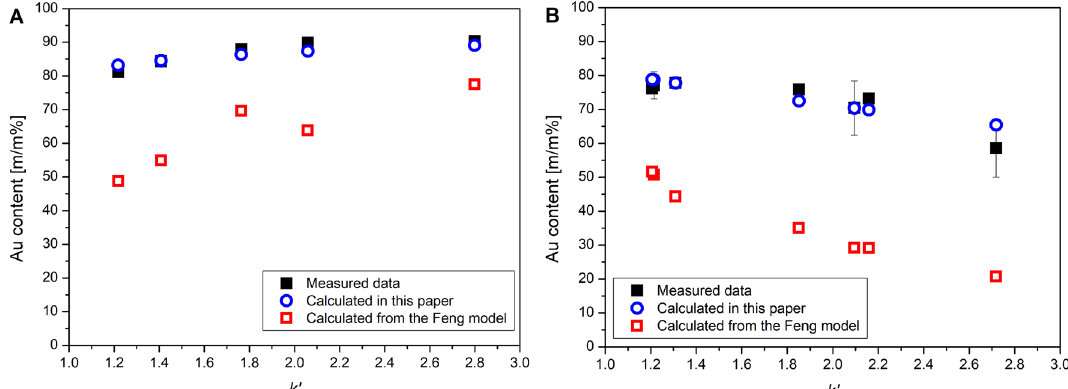
Figure 5. Comparison of the experimentally determined and the predicted, according to Eq. (5) and Ref. 31 , Au content of the generated BNPs as a function of the k’ factor when initially the cathode is gold ( A ) and silver ( B